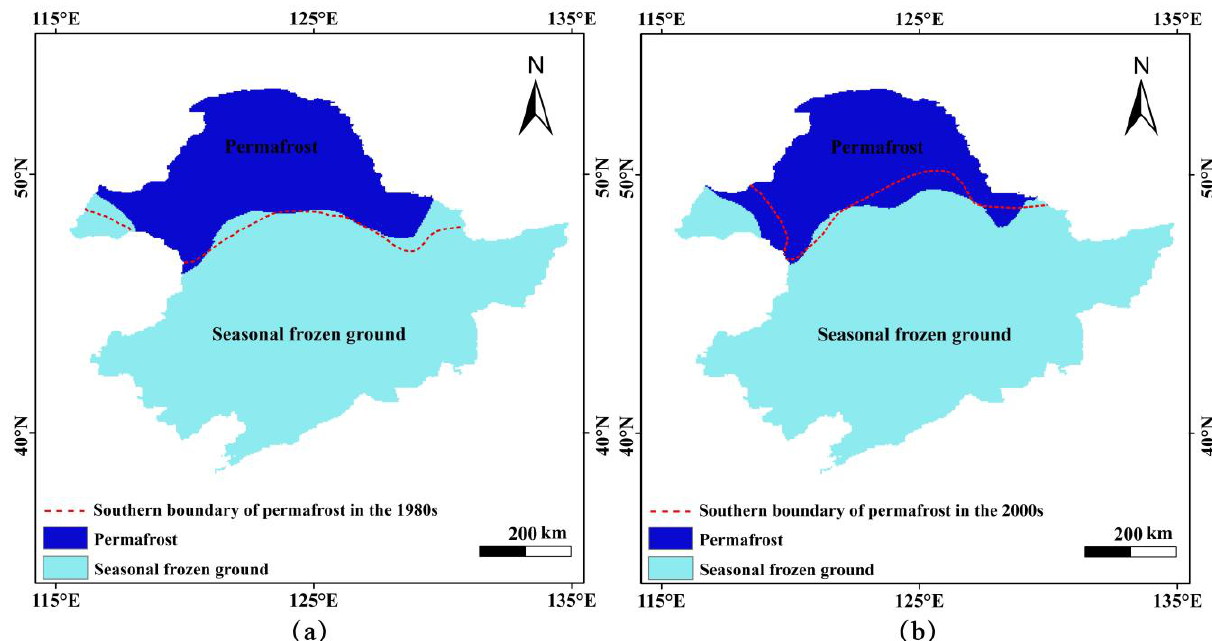
Figure 2. The spatial differences between the estimated permafrost distribution (blue shading) and the existing permafrost distribution map (north of the red line) in the ( a ) 1980s and ( b ) 2000s.